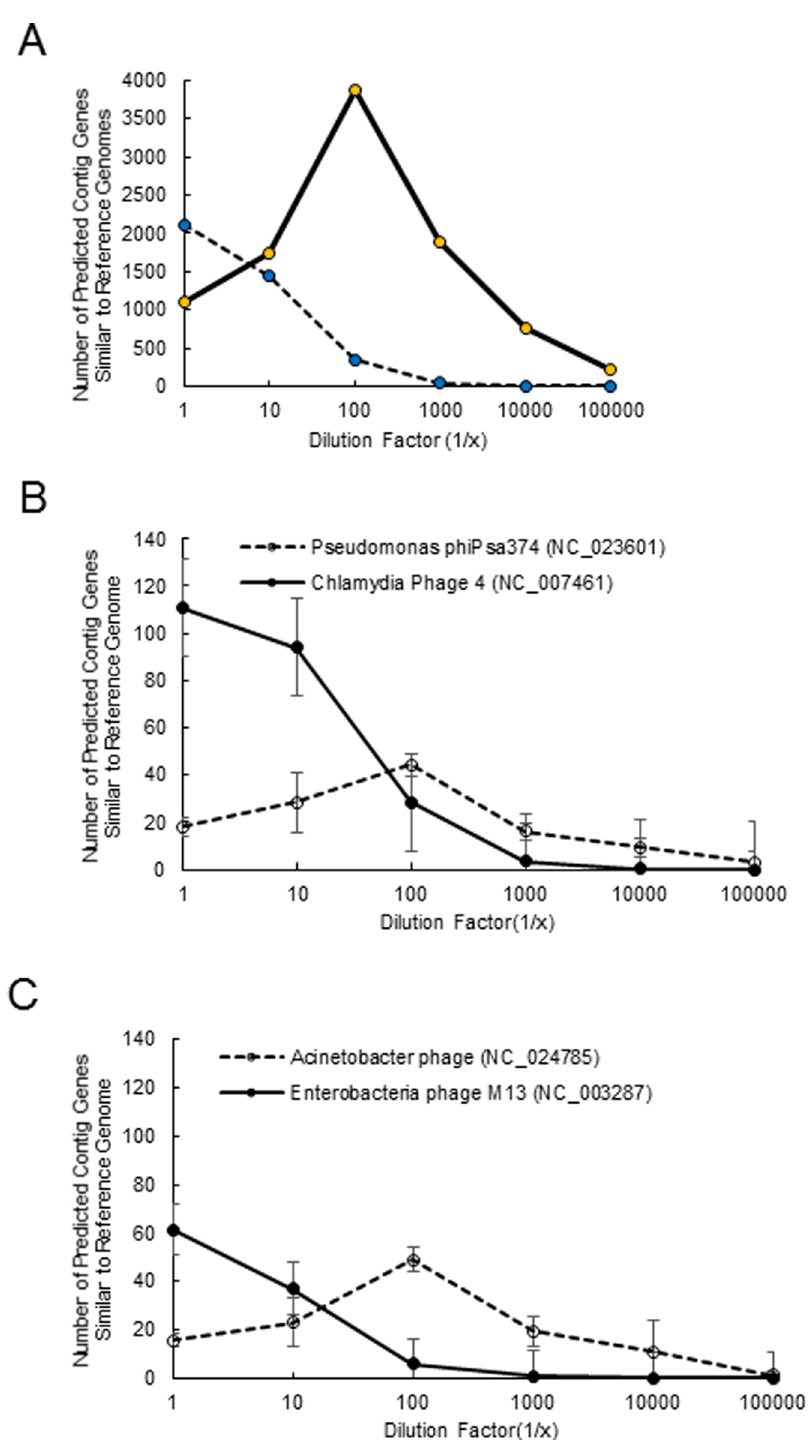
Fig 5. Comparison of relative abundance of bacteriophages with linear and circular genomes. A) ssDNA (blue circle) and dsDNA (orange circle) groups. B) Chlamydia phage 4 (NC_007461) (solid circle), vs.